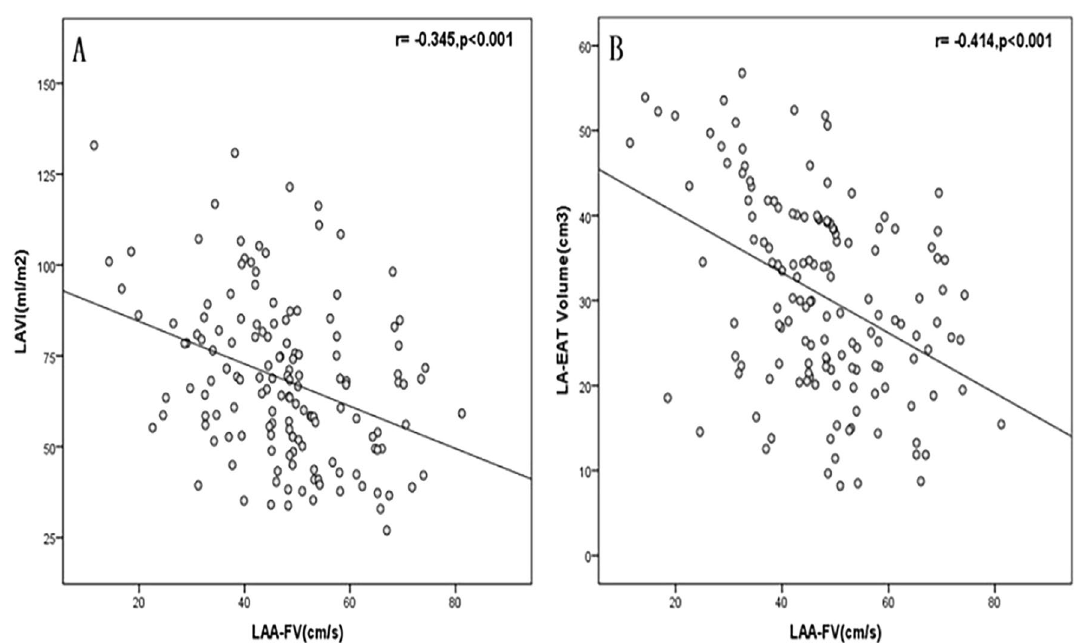
Figure 5. Correlation analysis showing that LAVI ( A ) and LA-EAT Volume ( B ) were significantly correlated with